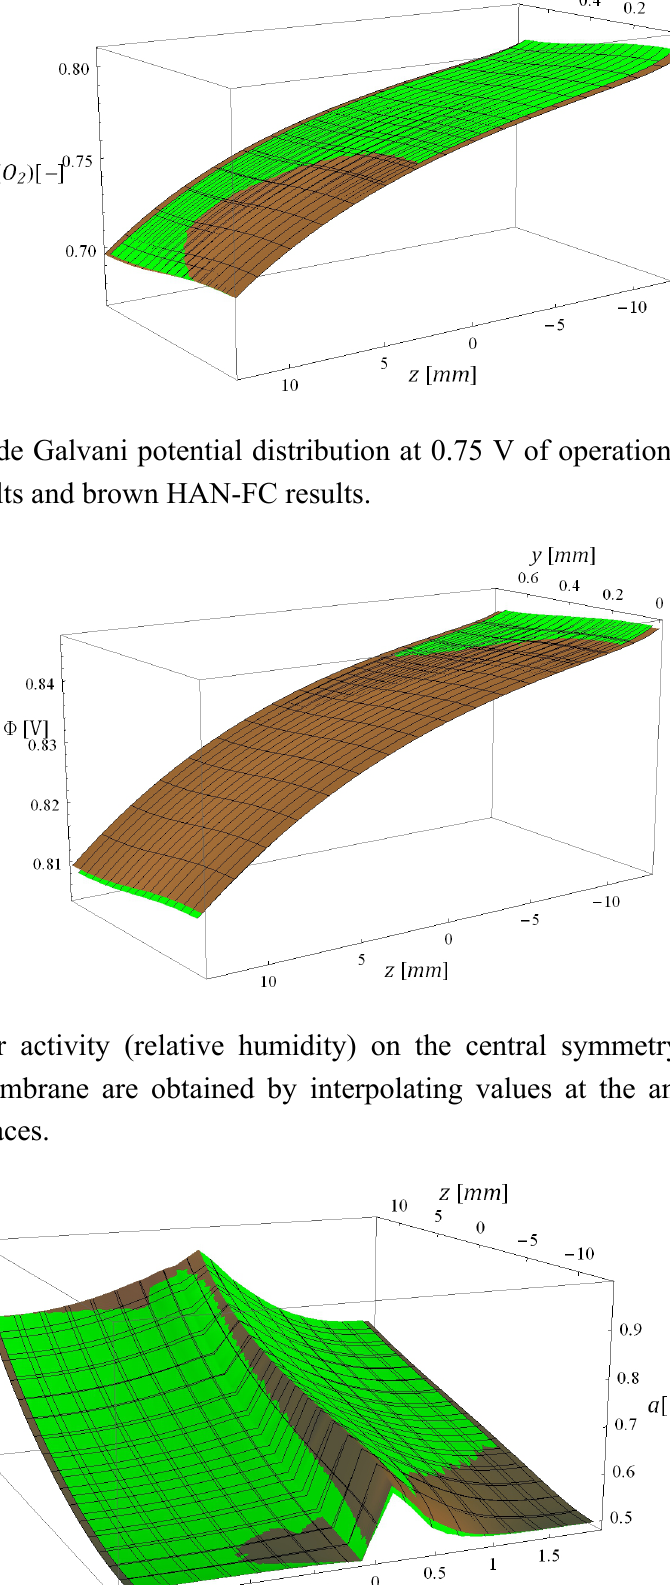
) at 0.75 V of (cid:2870)